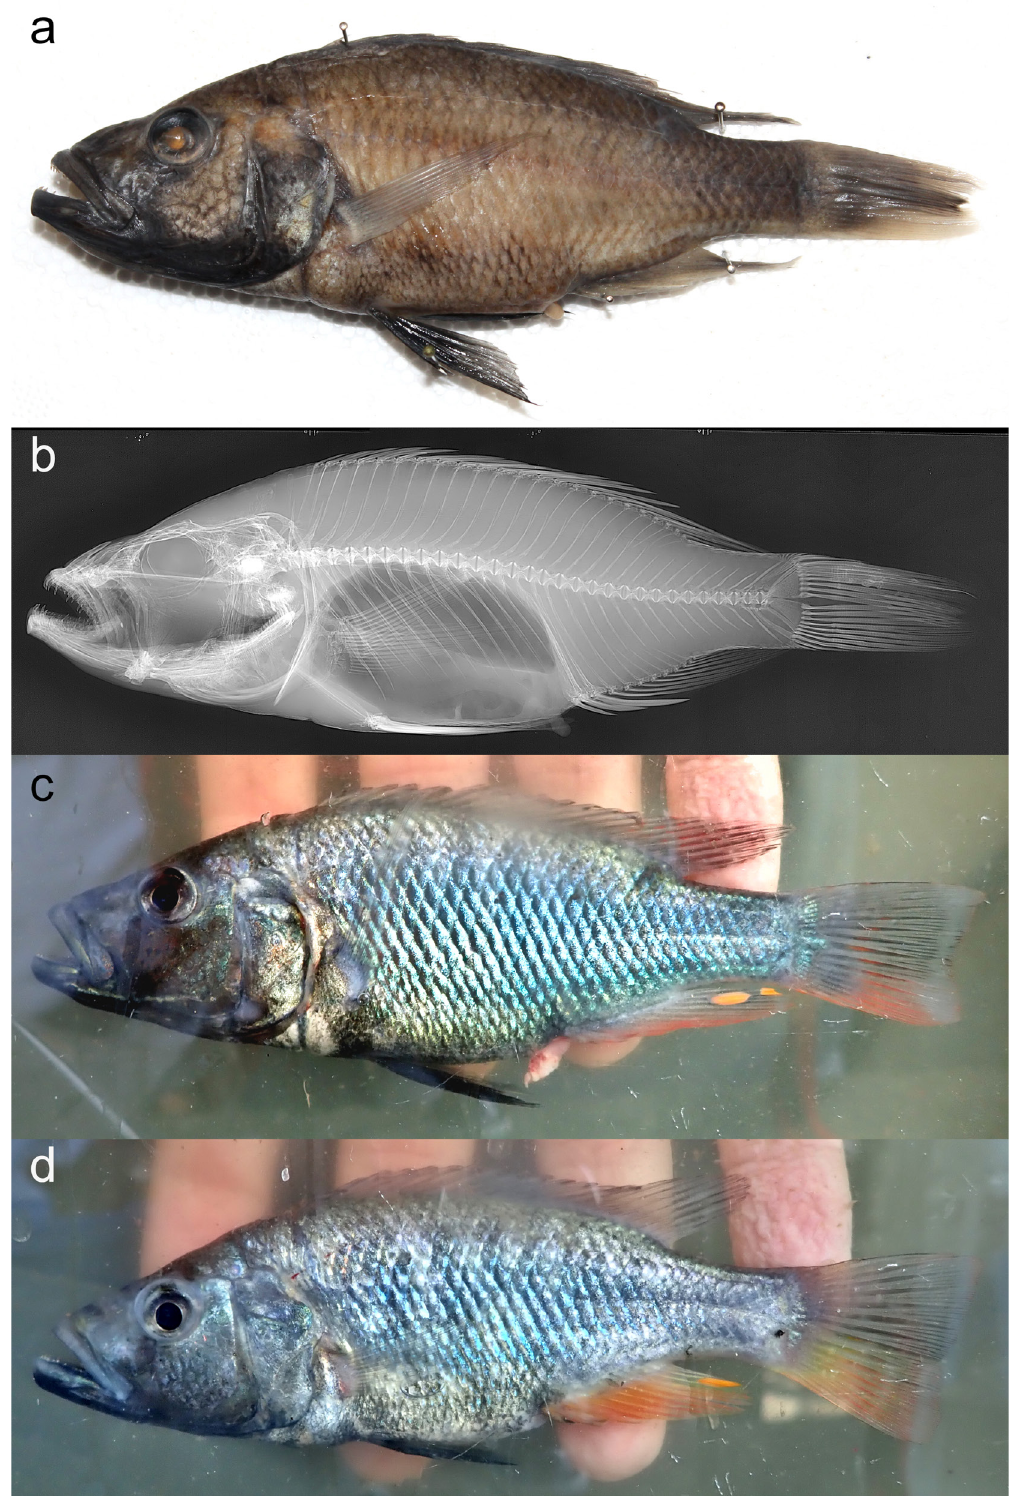
Fig. 18. Haplochromis glaucus sp. nov. a . Photograph of preserved holotype (RMCA 2019.002.P.0016; 106.2 mm SL). b . X-ray image of holotype c – d . Photographs of freshly caught specimens. c . Dominant male, the holotype. d . Female (RMCA 2019.002.P.0017; 102.1 mm SL) to illustrate the live colour patterns. The contrast was slightly